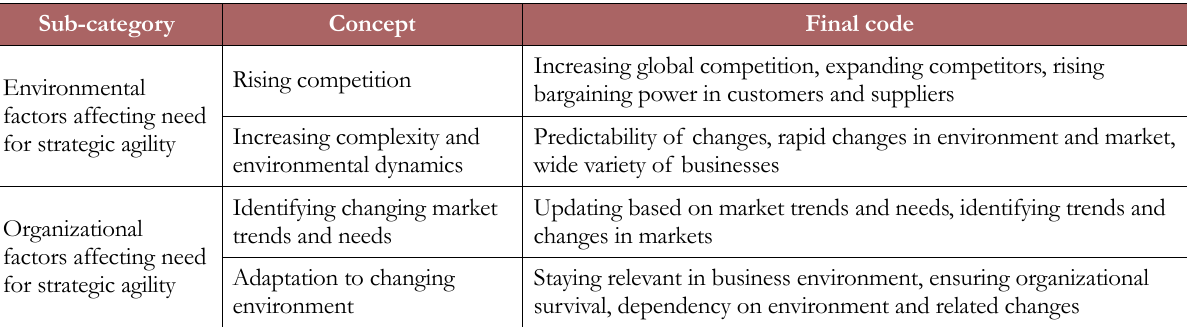
Table 3. Final codes, Concepts and sub-categories of causal